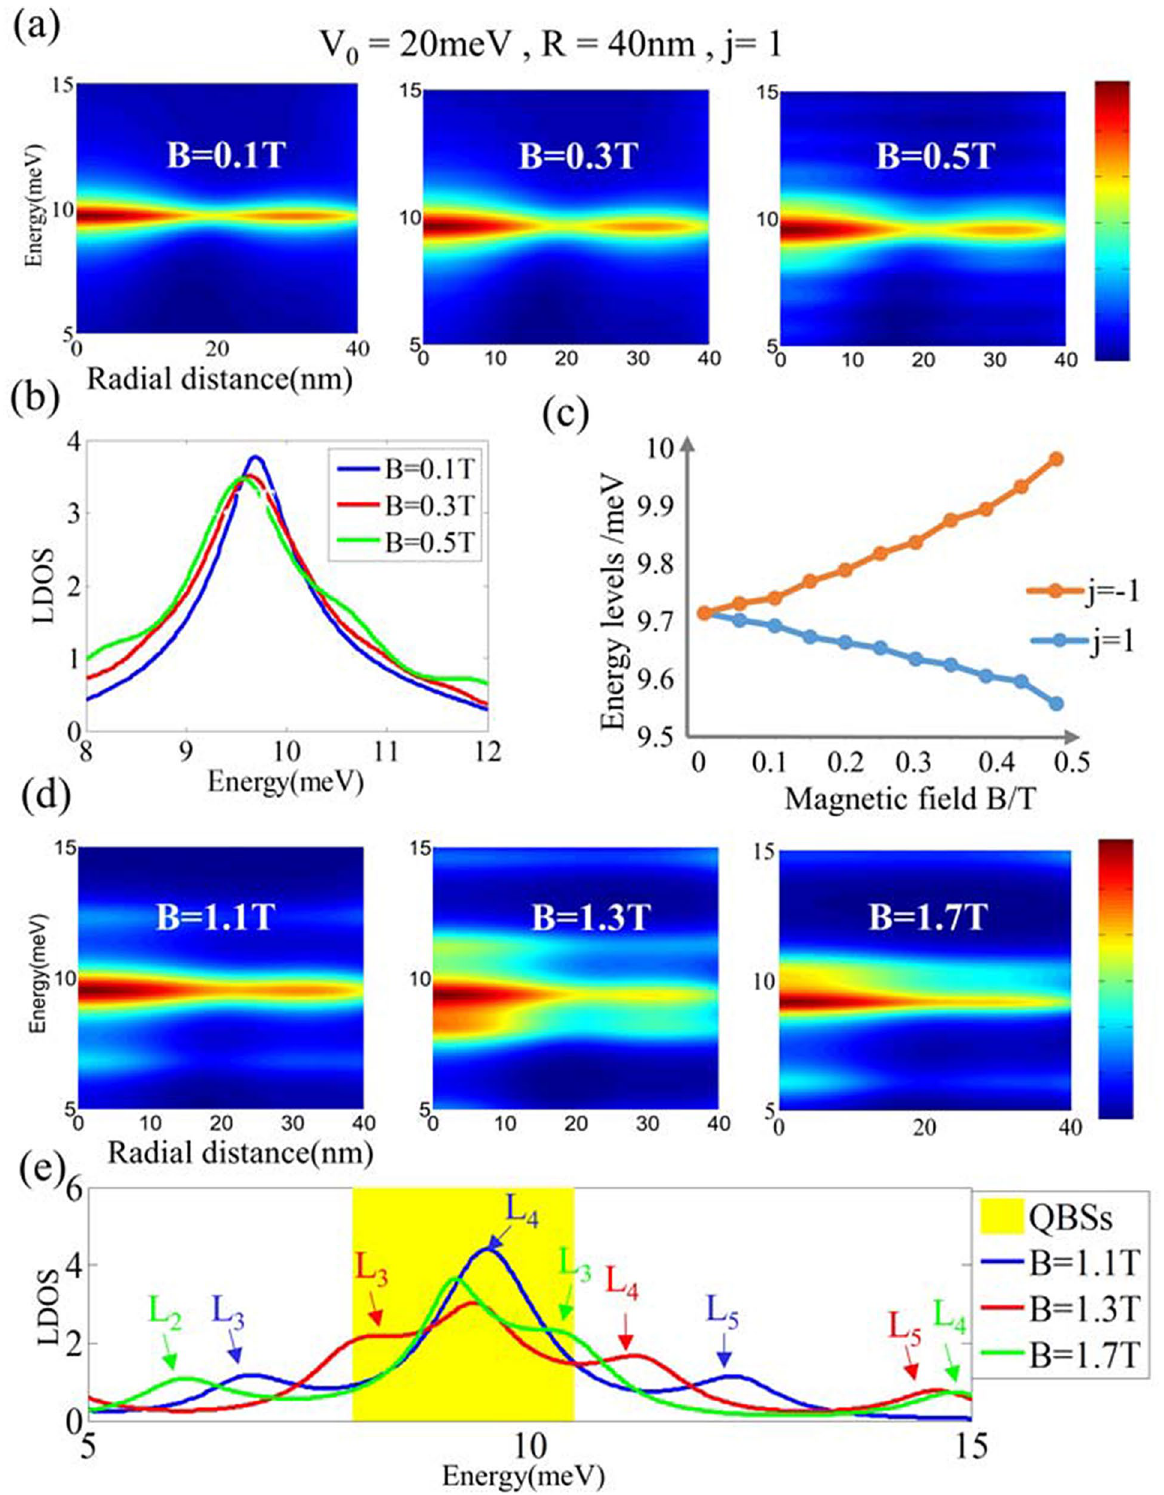
Figure 3. ( a , d ) show the evolution of the LDOS under relatively weak and strong magnetic fields, respectively. ( b , e ) show the detail effect on energy levels, respectively. Here, we plot the LDOS in logarithmical scale to show the magnetic field effect clearer, and the peaks in the yellow region indicate the QBSs energy levels. ( c ) Show 1 and j 1 as the function of magnetic field strength B . And the magnetic field the QBS energy levels for j = = − 1 mode and pull down those of the j 1 mode. ( e ), the arrows labeled L lift the energy levels for j x mark = − = 1.7 T (green) as an example, L 2 , L 3 and L 4 are BLG Landau levels with quantum the Landau levels. Taking B = 2, 3, 4 and the QBSs energy level is close to L 3 numbers n =